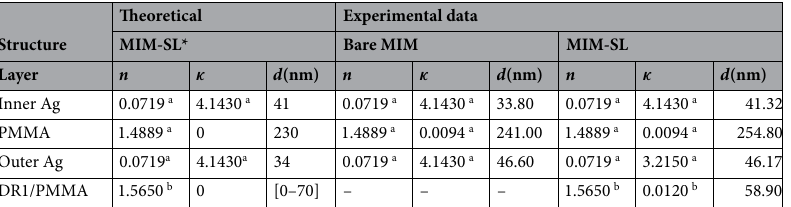
Table 1. Complex refractive index, at 632.8 nm , and thickness of the inner and outer layers of Ag, the PMMA sandwich layer, and the DR1/PMMA sensing layer. *Optimized lossless structure. a This paper. b From 10 .